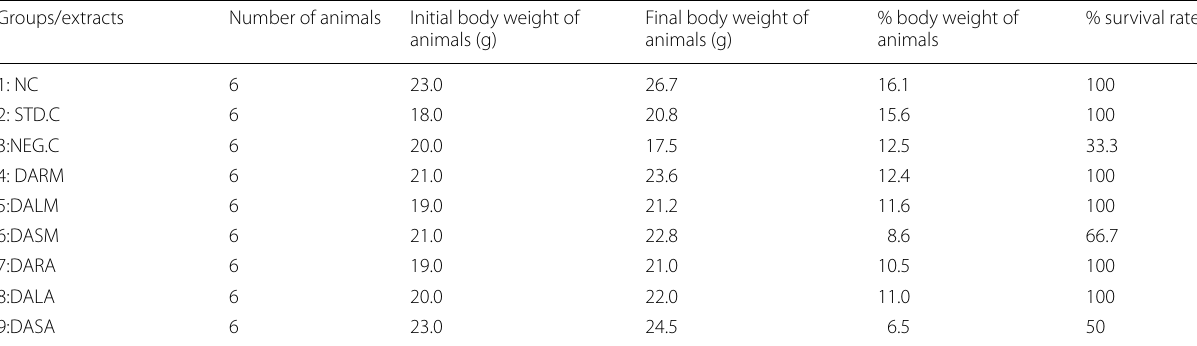
Table 6 Activities of crude aqueous and methanol extracts of roots, leaves and stem of D.arborescens on percentage body weight and survival rate of male Swiss albino mice infected with Plasmodium